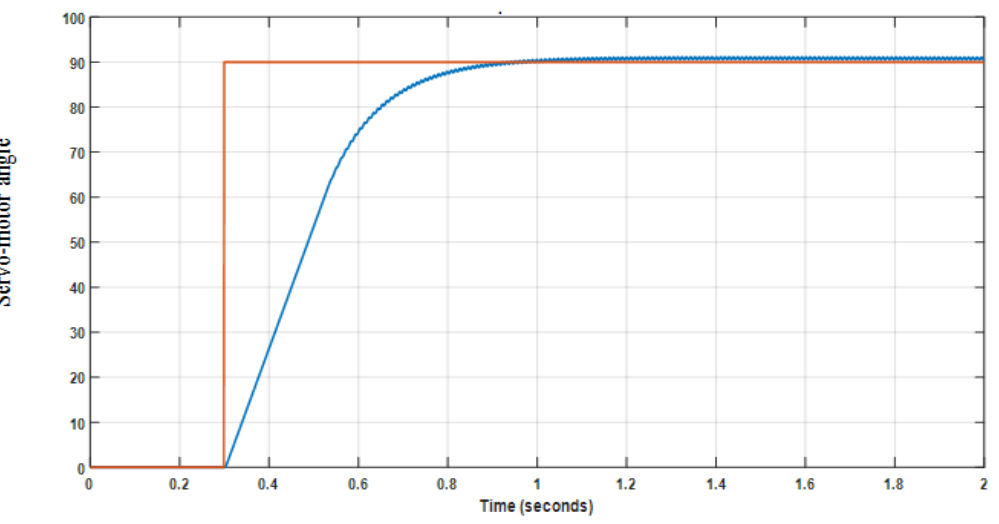
Figure 10. Step responses of a position ‐ control servo motor.